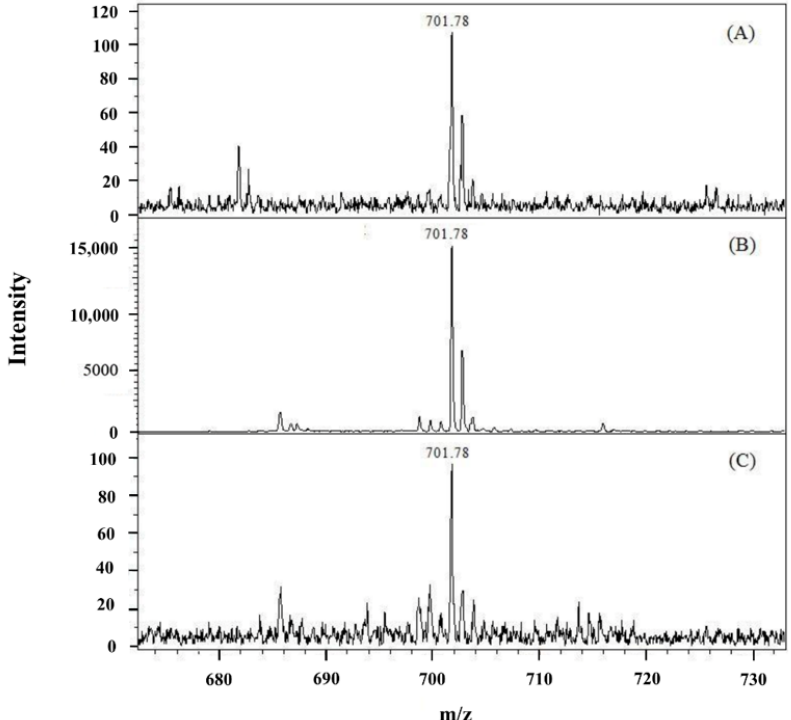
Figure 6. Mass spectra of ( A ) posaconazole (25.00 nM) obtained without EME, ( B ) posaconazole (25.00 nM) obtained with EME, and ( C ) posaconazole (0.10 nM) obtained with EME. The ion signal at m / z = 701.78 corresponds to the protonated molecular ion of posaconazole. Experimental conditions: sample volume, 8 mL; applied voltage, 80 V; stirring rate, 100 rpm; and extraction time, 15 min. All other conditions were identical to those outlined in Figure 2.